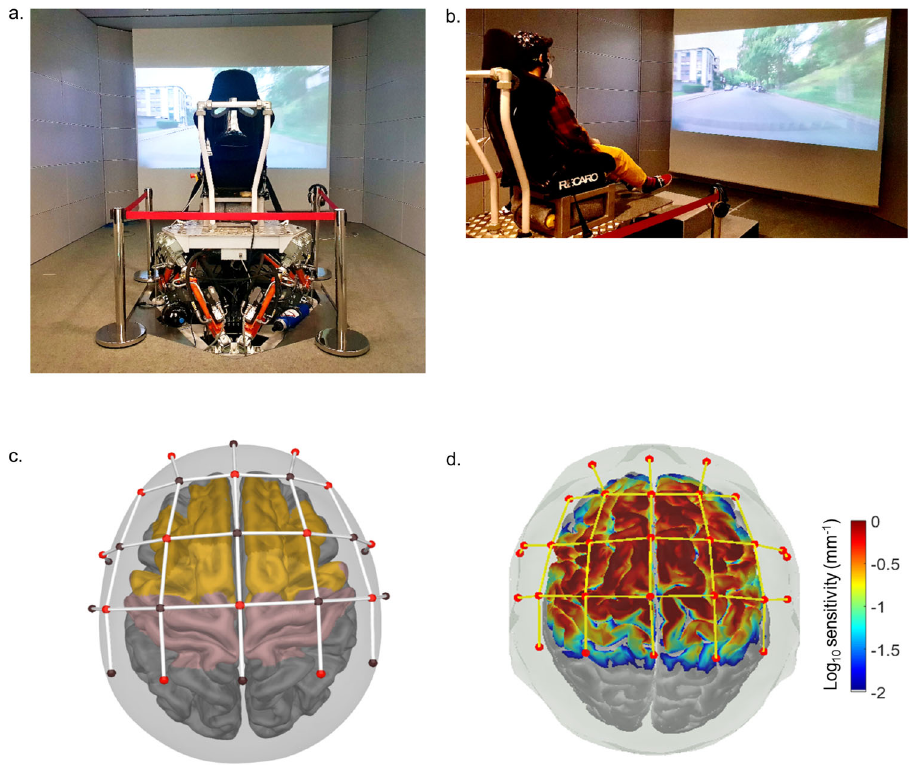
Fig. 1 Experimental setup of the multisensory virtual car riding environment and NIRS montage. a Vertical vibrotactile stimulation was displayed through a seat mounted on a hydraulic platform and an electrodynamic shaker. b Videos of moving road scenes were displayed on a wall-sized screen together with the corresponding audio recordings reproduced with a wave fi eld synthesis system with 464 loudspeakers in the room to provide contextual visual-auditory information for the vibrotactile stimulation. A participant wearing the NIRS cap sat on a seat in the virtual environment during the experiment. c The layout of the NIRS montage used in this study covered the dorsal lateral prefrontal cortex (dlPFC, dark yellow), premotor cortex with supplementary motor area (light yellow), primary motor, and primary somatosensory cortex (pink). d The sensitivity pro fi le of the montage indicates high sensitivity to optical density changes measured by each of the source-detector pairs in brain regions of (values shown here are on the log 10 scale of sensitivity values from 0.01 to